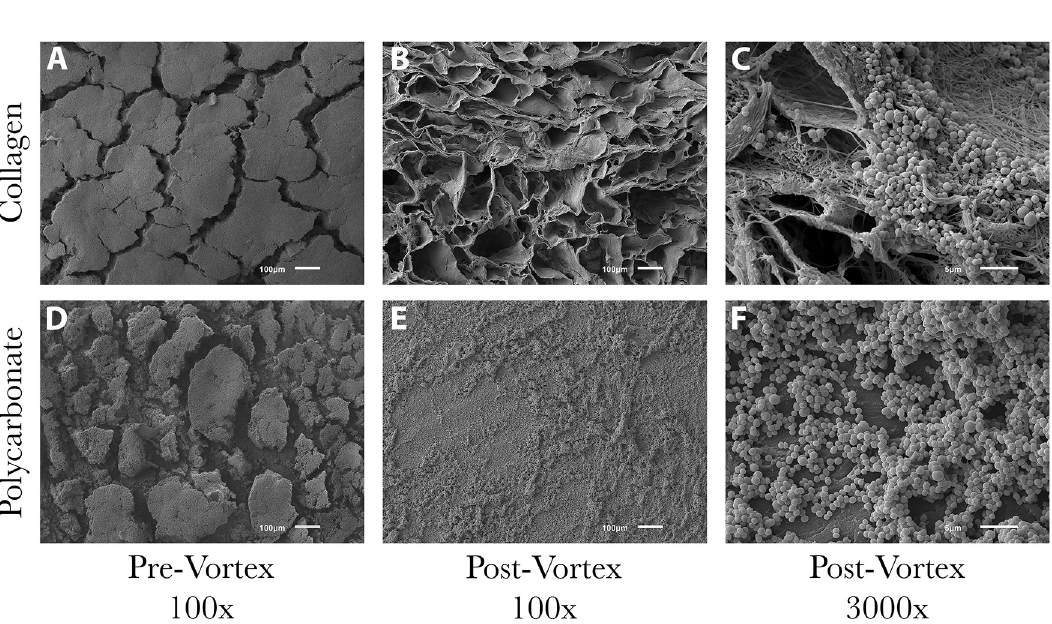
Fig 7. Representative SEM images of S . epidermidis ATCC 35984 biofilms on collagen and polycarbonate coupons pre- and post-vortex/sonication. (A) Heavy amounts of biofilm formed on collagen coupons, making the surface morphology unobservable. (B-C) Images showed that the large majority of biofilm burden had been removed by vortex/sonication, but clusters of cells still remained. (D) Similar to collagen, large plumes of biofilms formed on polycarbonate coupons with deep ravines. Although these ravines may have formed during the dehydration procedure, it is likely they were sites of water channels that provided fracture points within the biofilm communities. (E-F) Images showed that there was still a fair amount of surface coverage by biofilms post-vortex/ sonication. However, it was estimated that there were < 5% of cells remaining on the surface similar to other bacterial isolates examined.